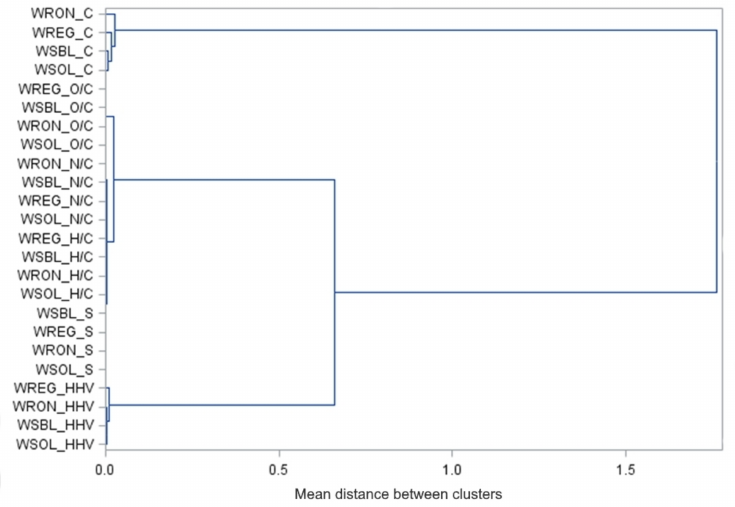
Figure 2. Comparison of analyzed waste shoots of selected grapevine varieties in relation to energy